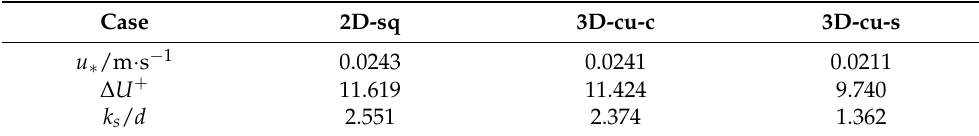
Figure 7. Normalized velocity profiles for predicted results and experiment data [9]. Table 2. Statistics of different flow resistance parameters. Table 2. Statistics of different flow resistance